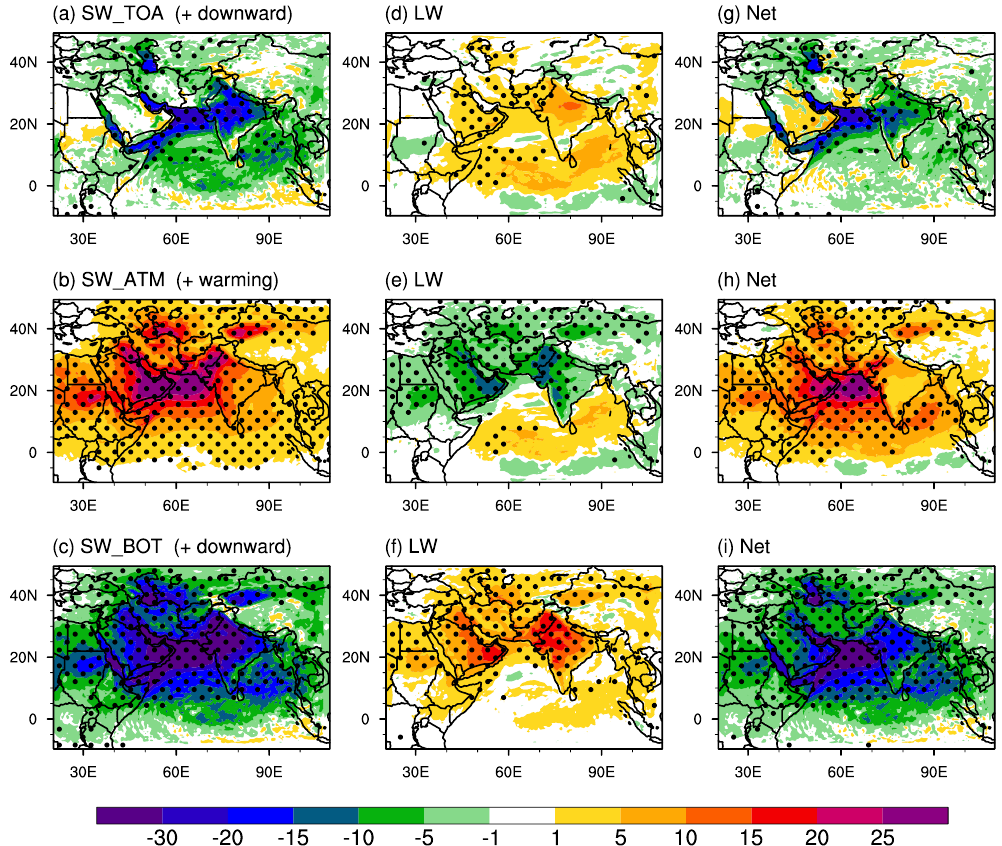
Figure 11. Spatial patterns of dust direct radiative forcing (Wm − 2 ) at the top of the atmosphere (TOA), in the atmosphere (ATM), and at the surface (BOT) averaged during JJA 2008 at all-sky conditions. Calculated from the ensemble mean differences between ALLF and NDST ex- periments. Downward radiation is defined as positive at the TOA and the surface; therefore, positive (negative) value means absorb/warming (irradiate/cooling) effects in the atmosphere. Net radiative effect is the sum of SW and LW radiative effect. The dotted areas indicate that the radiative effect has a 95% confidence level based on a one-sided Student’s t